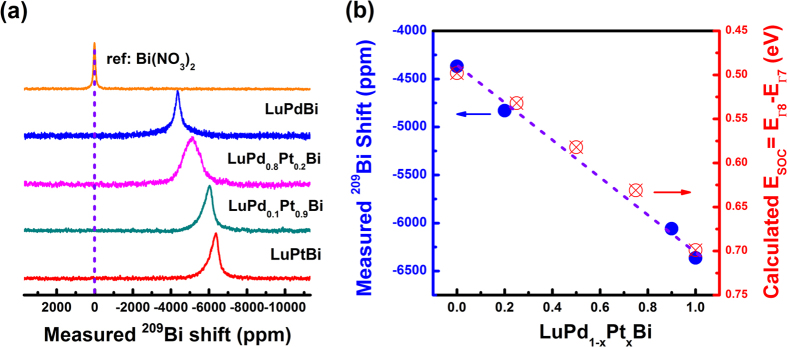
209Bi NMR spectra in isoelectronic alloys LuPd1-xPtxBi (x = 0, 0.2, 0.9, 1).(a) Typical 209Bi powder spectra of half-Heusler alloys LuPdBi, LuPd0.8Pt0.2Bi, LuPd0.1Pt0.9Bi and LuPtBi. All spectra are normalized with respect to peak intensity. The peak positions are referenced to Bi(NO3)2 in aqueous solution. (b) The measured NMR 209Bi isotropic shifts and the calculated SOC parameter ESOC for the half-Heusler system LuPd1-xPtxBi.